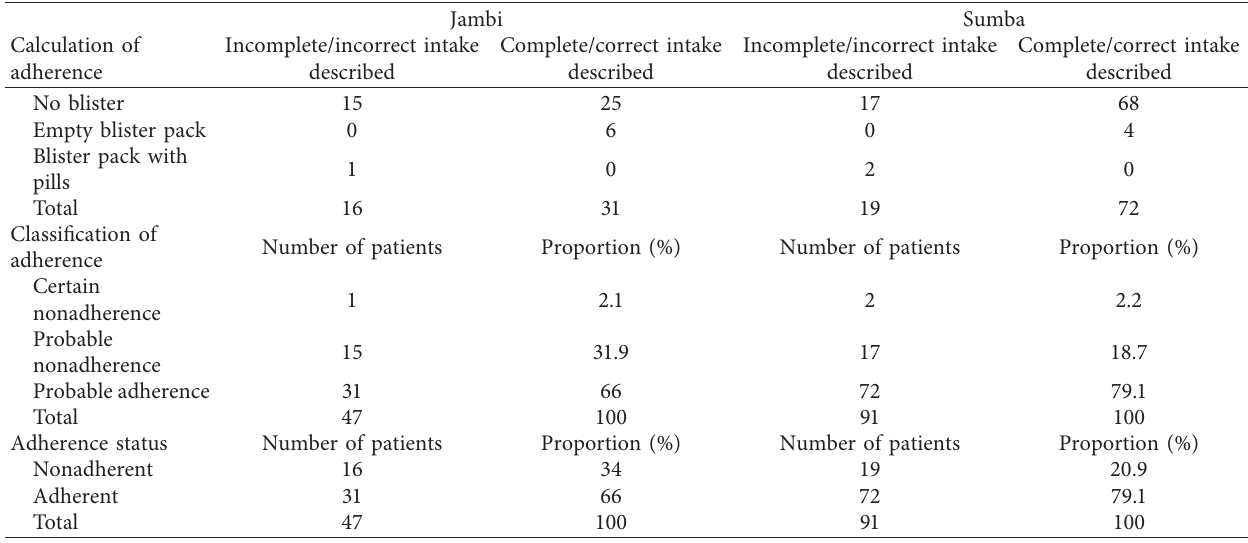
Table 3: Adherence to DHs regimen among population in Jambi Province and Sumba Island, Indonesia.